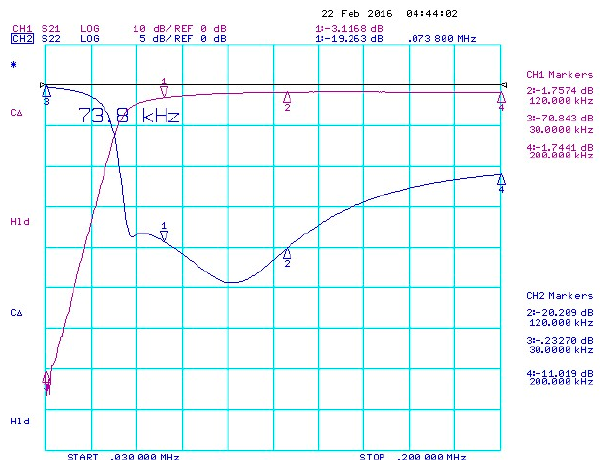
Figure 11. Performance of the high-pass filter.